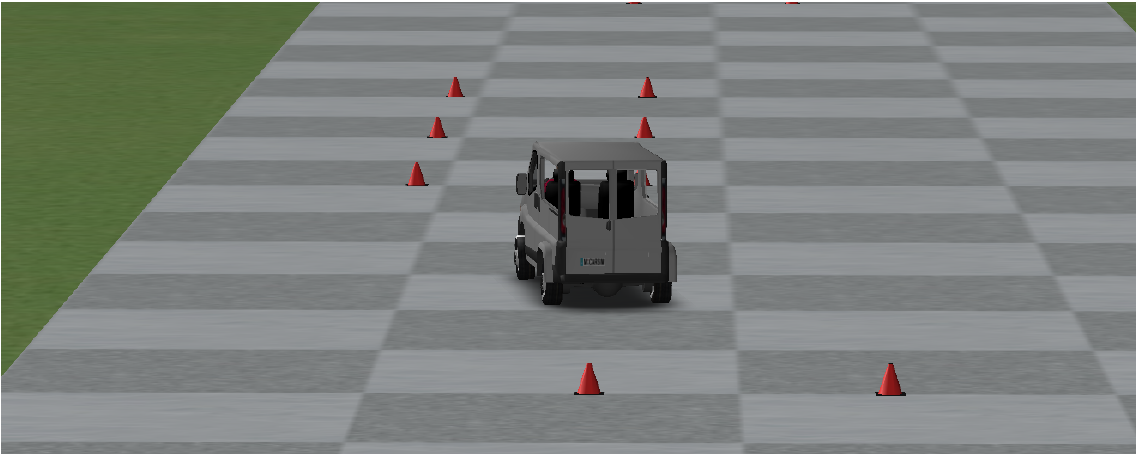
Figure 9. Test 2: Double lane